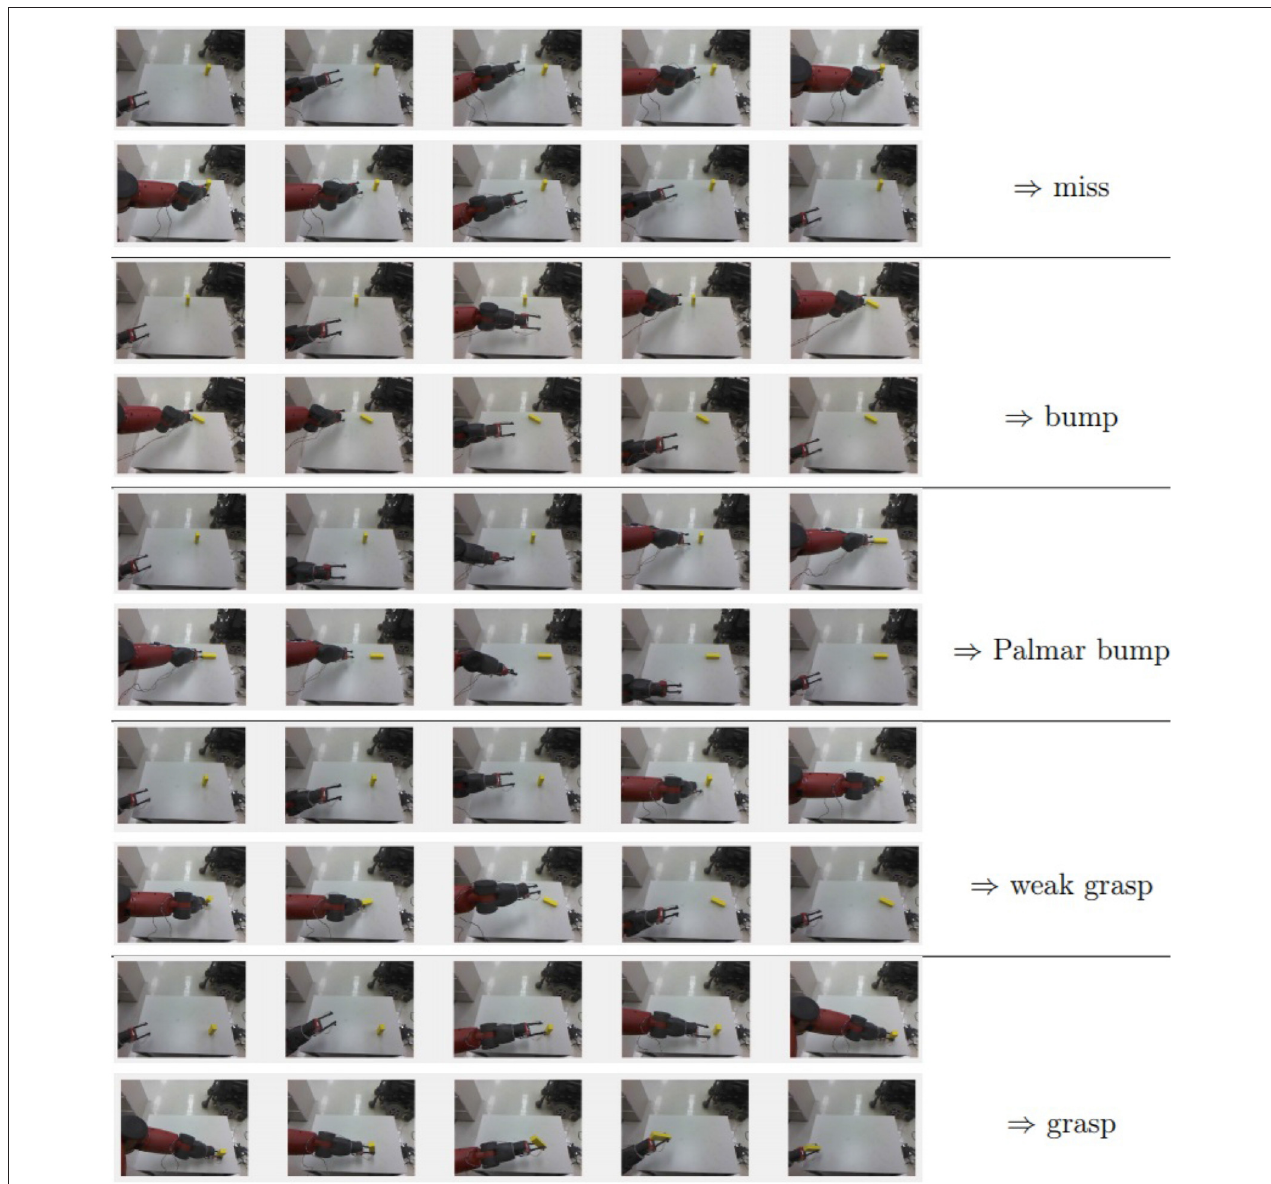
FIGURE 8 | The agent’s RGB percepts during attempted grasp trajectories. Images for the forward portion toward n f are shown in the first of each pair of rows, and images for the portion to return to n h are shown in the second rows. Images for some nodes in the middle of trajectories with more than five nodes have been omitted. The agent classifies the result of the grasp attempt by observing the state of the target object during the trajectory. In all cases but miss , there is a substantial change between the first and last observations, and the trajectory is a successful reach. In all other cases these observations should be significantly different, and the reach component of the grasp was successful. Further classification depends on the state throughout the return trajectory and if the Palmar reflex was activated, as discussed in section 5.1.1. Only the result of the final example is considered to be a successful